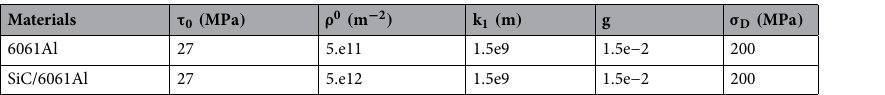
Table 2. The dislocation density hardening parameters of the 6061Al matrix and the 30 vol.% SiC/6061Al composites.